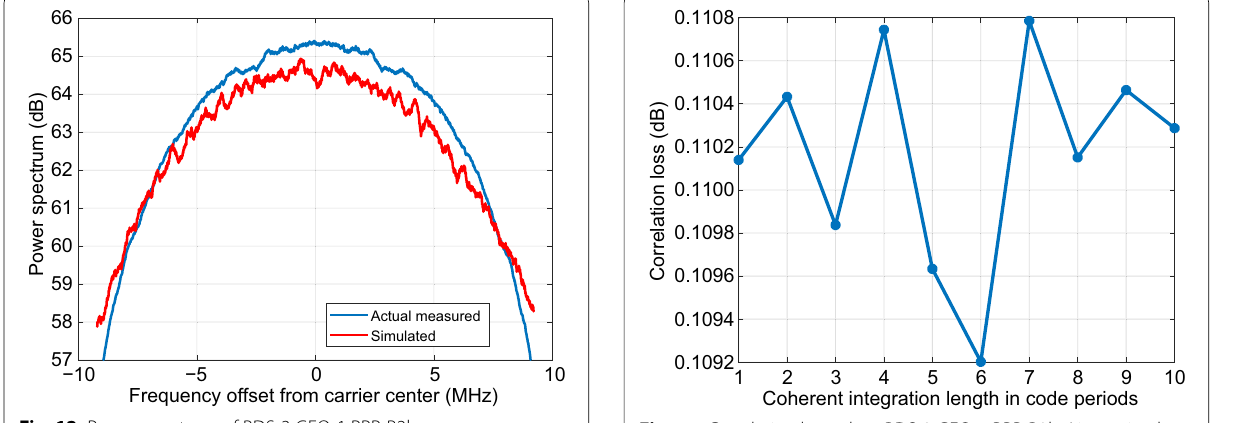
Fig. 14 Correlation loss when BDS-3 GEO-1 PPP-B2b_I is received